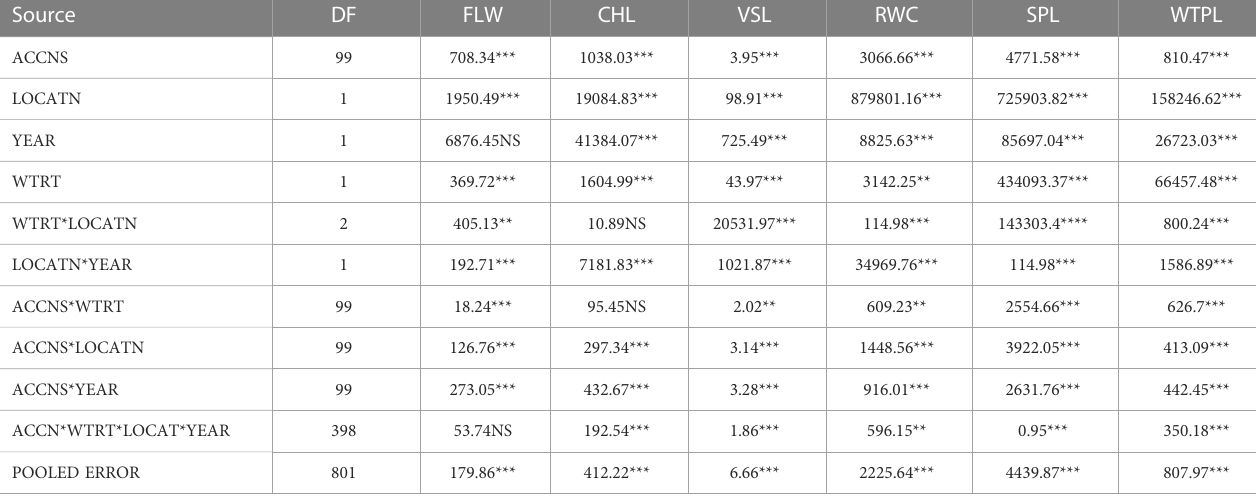
TABLE 2 Mean squares for the traits for 100 accessions of Bambara groundnut planted in Ibadan and Kano in the 2015/16 and 2016/17 planting seasons. Source